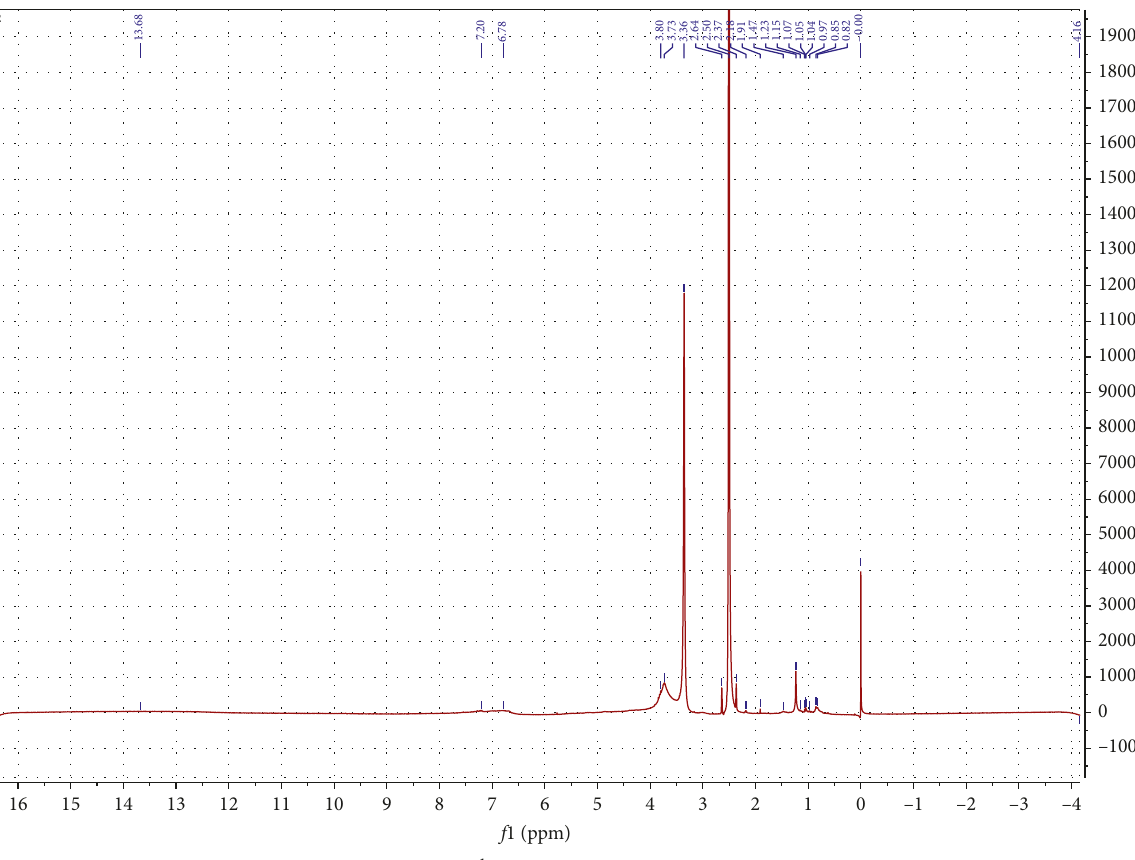
Figure 6: 1 H-NMR spectrum of LPCAs. Table 1: The determination result of the content of functional groups of